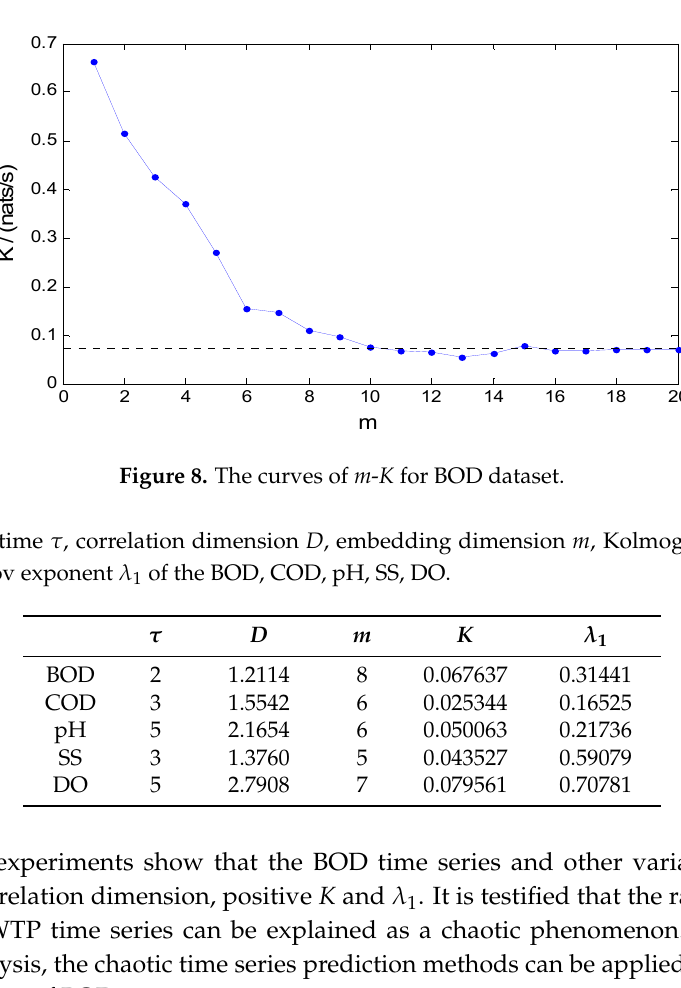
Figure 7. Two ‐ dimension phase space portrait of BOD dataset.